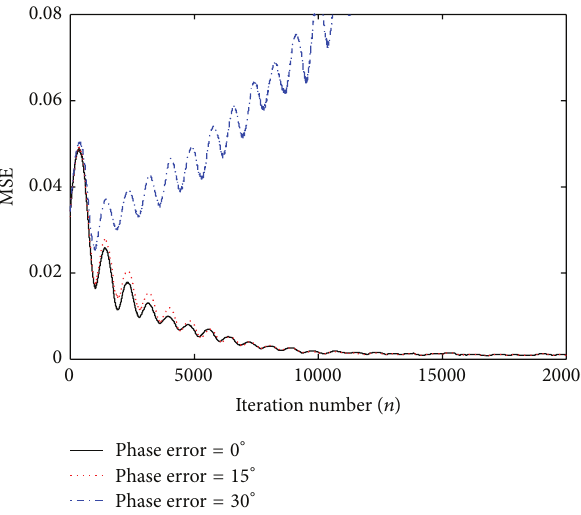
Figure 14: The MSE using the feedforward control under different phase errors of the cancellation